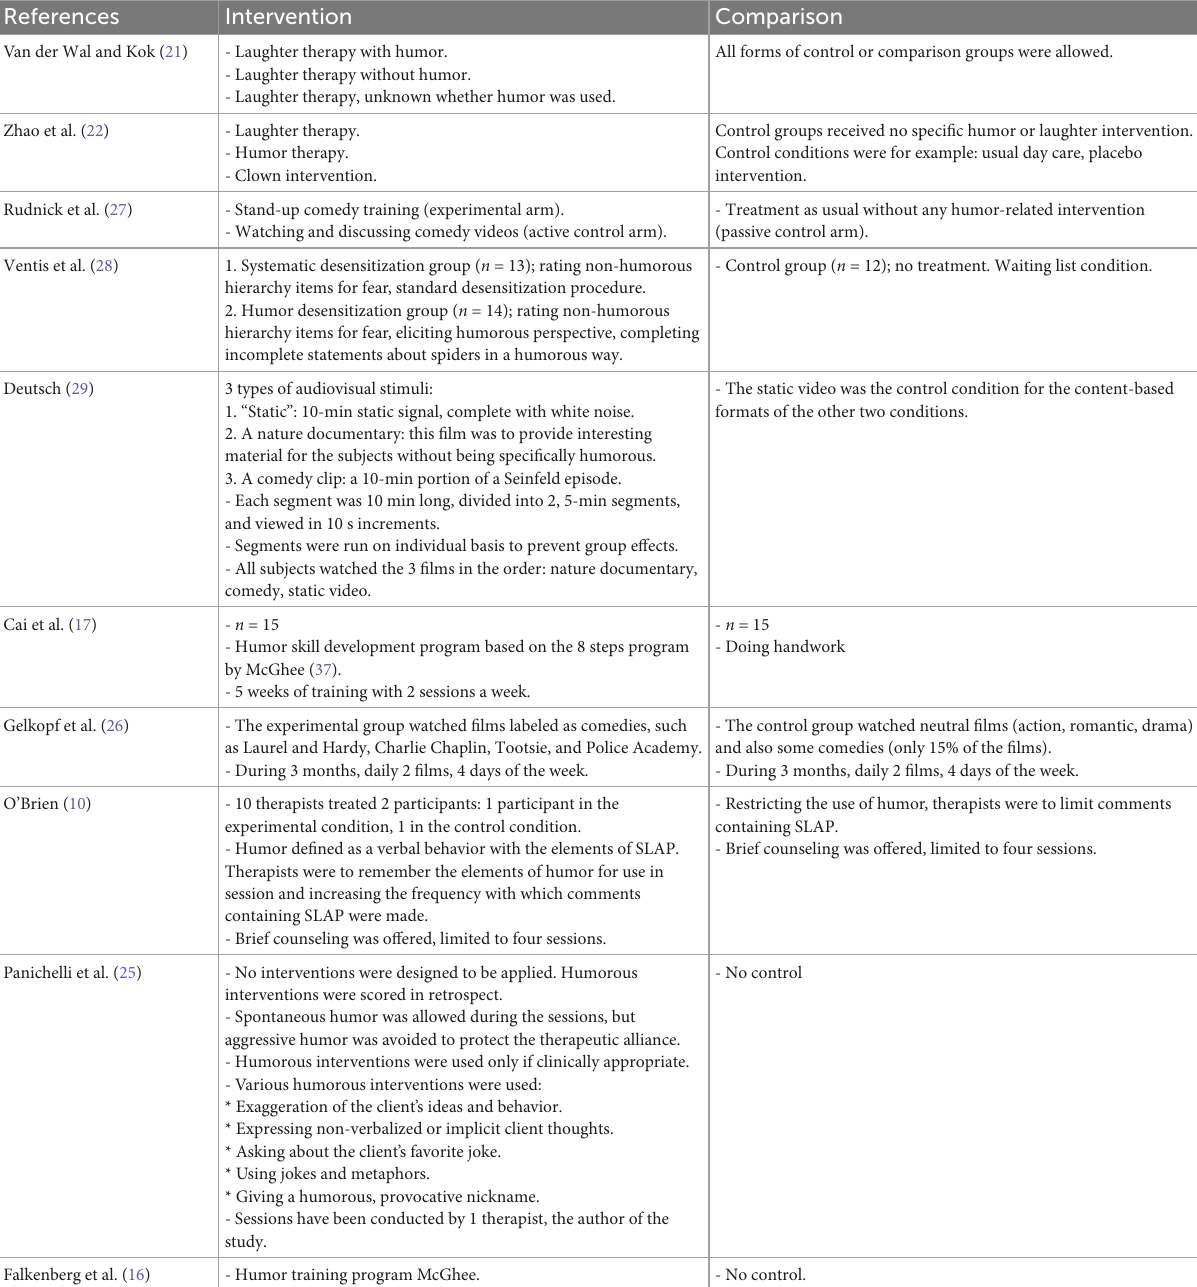
TABLE 2 Interventions and control